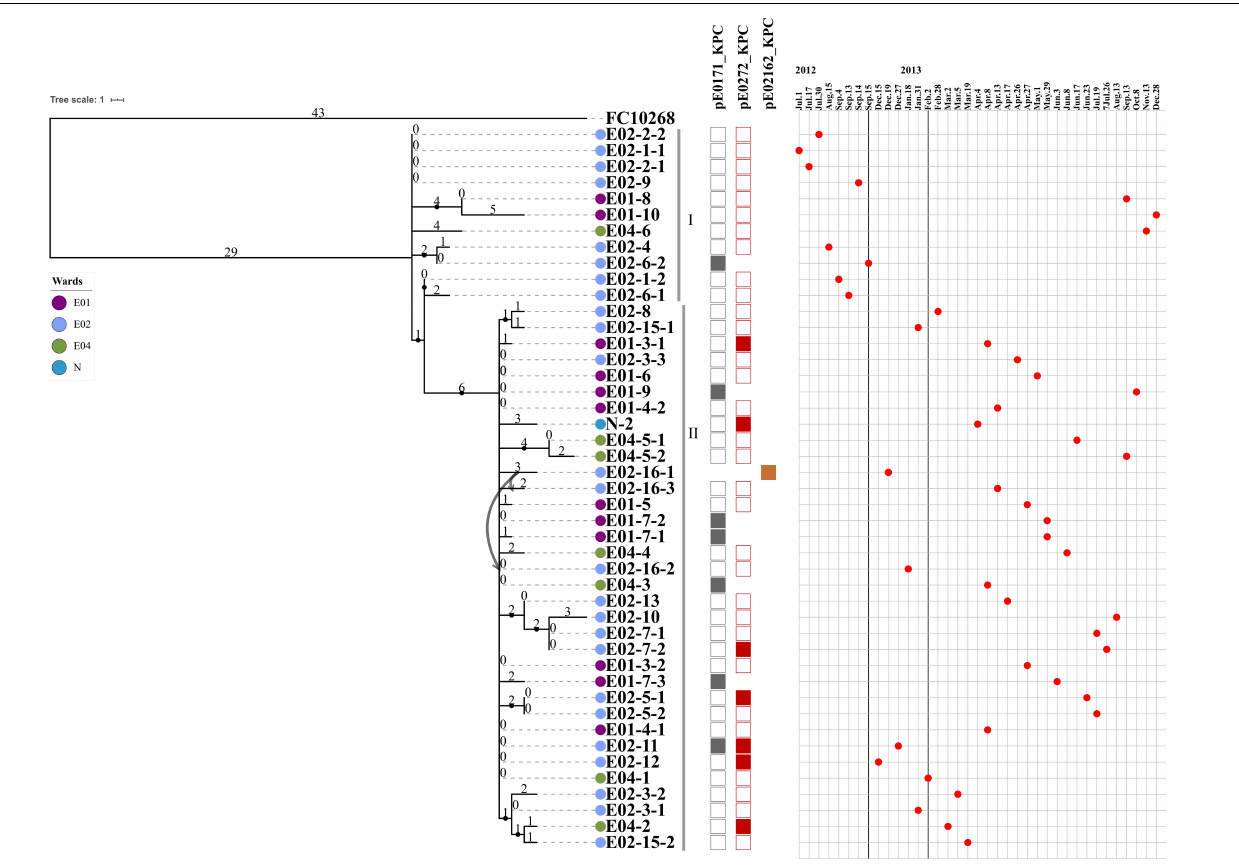
FIGURE 2 | The maximum parsimony phylogenetic tree based on SNP and information about 45 ST131 E. coli strains and the reference genome FC10268. Tree number four out of the ten most parsimonious trees (length = 136) is shown. The consistency index, retention index, and composite index were each 1.000000 for all sites and parsimony-informative sites. Only bootstrap (1,000 replicates) values greater than 60% are shown. The strain IDs are labeled using three strings of characters, separated by a hyphen. The first string of characters represents the ward of the patient from whom the strain was isolated, E01, E02, E04, and N1. The second string of characters represents the patient number. The third string of characters represents the strain isolated from that patient. Lavender indicates the E01 ward, light blue indicates the E02 ward, green indicates the E04 ward, and dark blue indicates the N1 ward. The curved lines indicate that patients E02-16 were transferred from the E02 ward to the E04 ward. The SNP number is marked on the middle of branch. The strains of Cluster I and Cluster II are marked with gray vertical lines. Strains carrying the pE0171_KPC plasmid backbone, the pE0272_KPC plasmid backbone, or the pE02162_KPC plasmid backbone are indicated by gray, red, or brown squares, respectively. The bla KPC − 2 -positive plasmid in the strain is displayed above the column of corresponding color-filled squares. The strains are arranged in the chronological order in which the samples from which they were isolated were collected.